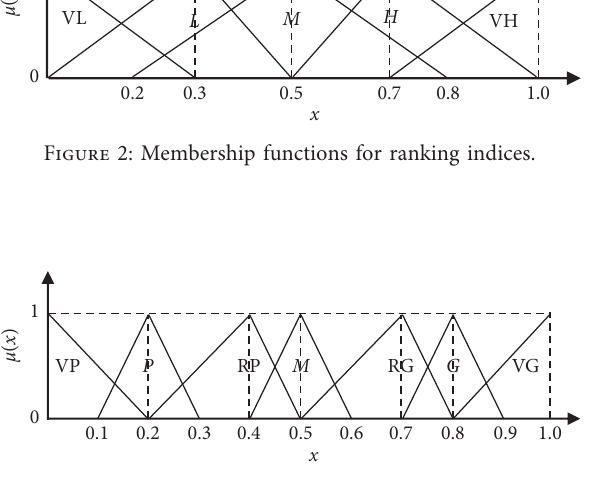
Figure 3: Membership functions for ranking